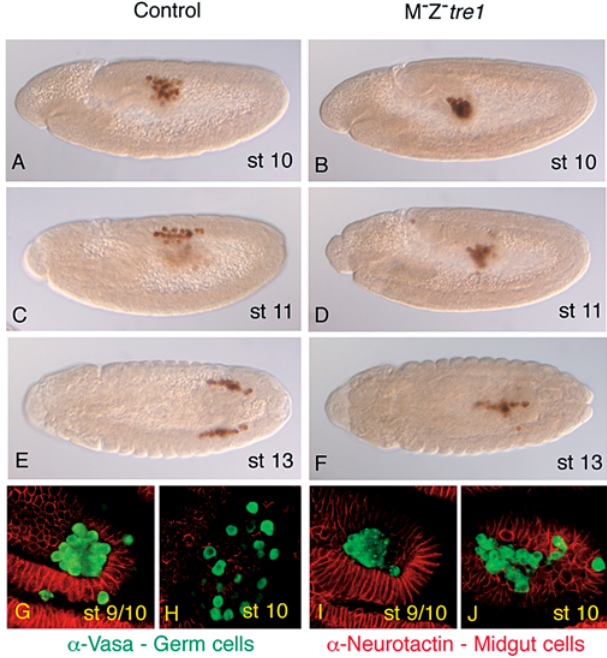
Figure 3. The Phenotype of M (cid:1) Z (cid:1) tre1 Mutant Embryos Anterior is left in all figures. (A–F) Embryos are stained with anti-Vasa (brown) to mark germ cells. (A–D) Lateral views. (E–F) Top views. (A), (C), and (E) are wild-type embryos. (B), (D), and (F) are tre1 mutant embryos. Wild-type germ cells migrate out of the PMG at stage 10 (A) and migrate toward mesoderm at stage 11 (C) and finally to the gonad at stage 13 (E), but in tre1 mutant embryos, germ cells fail to leave the PMG ([B] shows stage 10 and [D] shows stage 11) and are mostly found ‘‘ clumped ’’ together in the middle of the gut at stage 13 (F). (G–J) High magnification view of wild-type (G and H) and tre1 mutant (I and J) embryos stained with anti-Neurotactin (red) to mark cell membranes of midgut epithelium and germ cell-specific anti-Vasa (green). Wild-type germ cells are migrating out of the PMG at early stage 10 (G) and are outside of the PMG and thus at a different optical plane than PMG at late stage 10 (H). tre1 germ cells, in contrast, do not migrate out of the PMG at stage 9/10 (I) and are still left inside the PMG and thus at the same optical level as the PMG cells at late stage 10 (J). Punctate appearance of anti-Vasa staining in tre mutant germ cells is likely due to heat fixation protocol used as it can also be observed in wild-type germ cells (data not